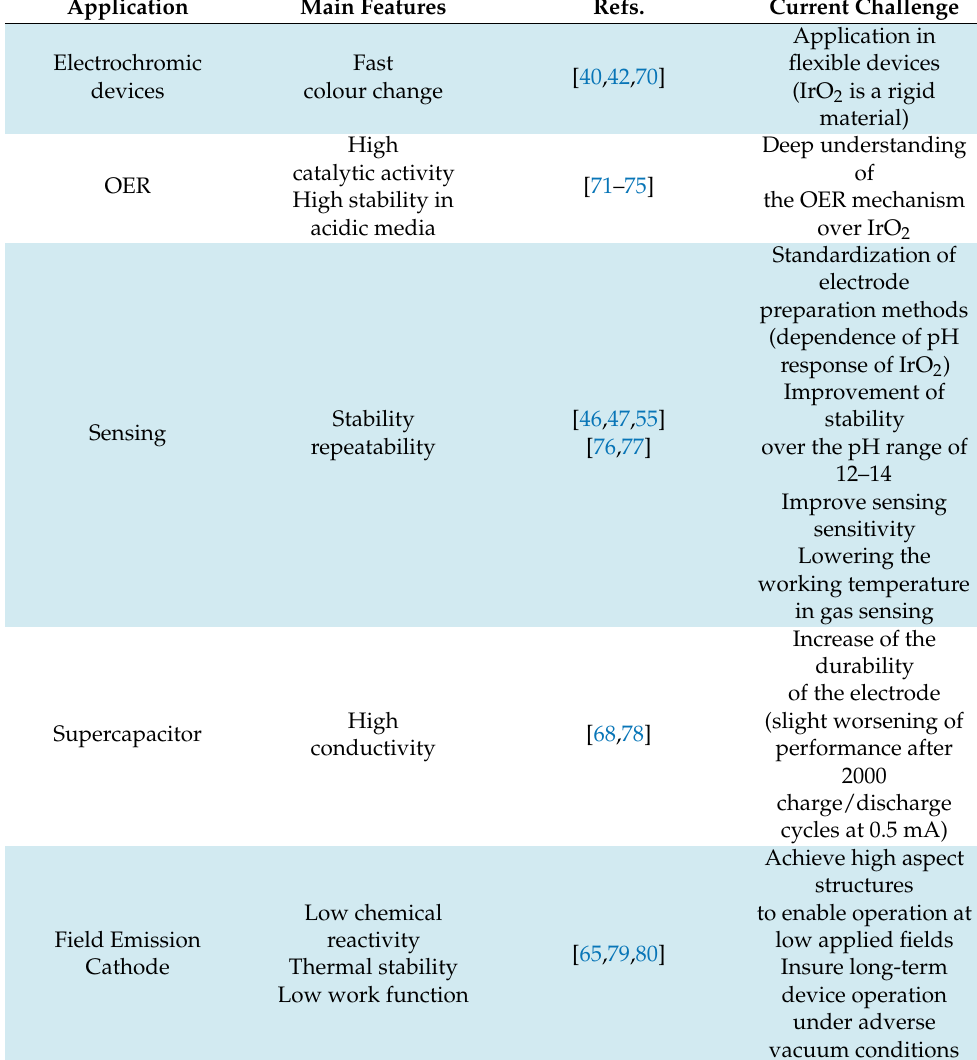
Table 2. Main applications of IrO 2 -based